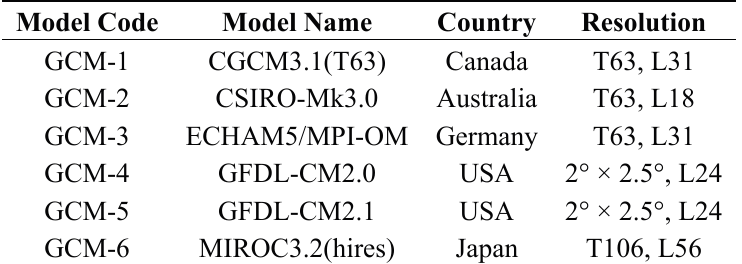
Figure 1. The basic information of the study area: ( a ) Tseng-Wen Reservoir catchment; ( b ) rainy days; ( c ) mean monthly rainfall; and ( d ) mean monthly flow. Table 1. Summary of the GCMs used in the